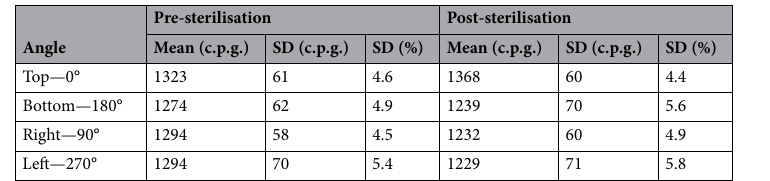
Table 1. Mean and SD of the PCR for each angle considered.